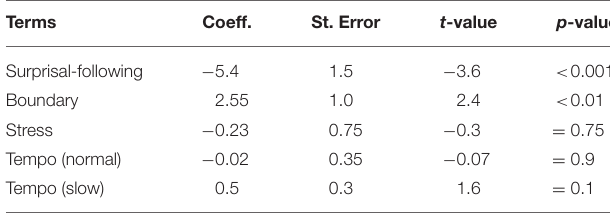
TABLE 11 | Additive model of consonantal COG: surprisal and prosodic effects.